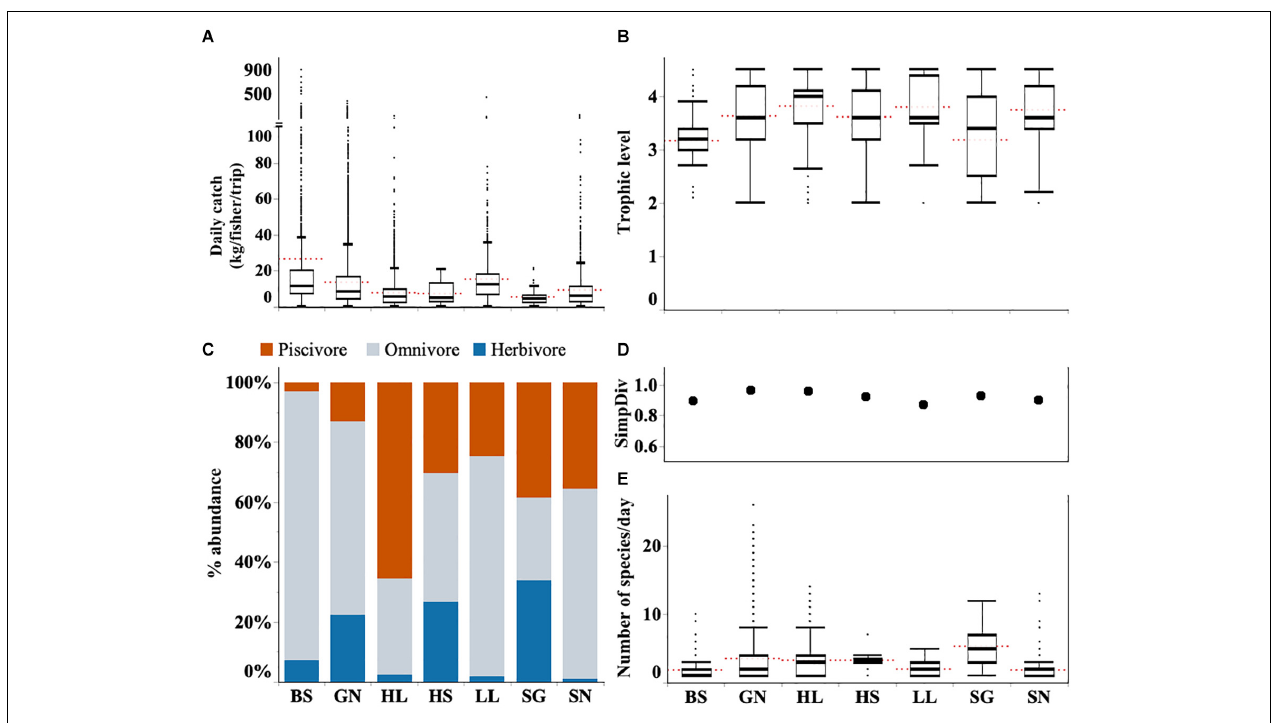
FIGURE 4 | Graphs show (A) daily catch rate per fisher (kg/fisher/trip) (B) trophic level of catches (C) proportions of catch by trophic level (D) diversity (Simpson’s diversity index) and (E) species richness (SpR) for each gear type (BS, Beach seine ; GN, Gill net ; HL, Handline ; HS, Hand-spear ; LL, Longline, SG, Spear-gun ; SN, Shark net). Boxplots show the median and the range between the percentile 25 (lower quartile) and 75 (upper quartile), and whiskers 1.5 times IQR. Red dotted line indicates the mean. Full descriptive statistics provided in Supplementary Table S4 .